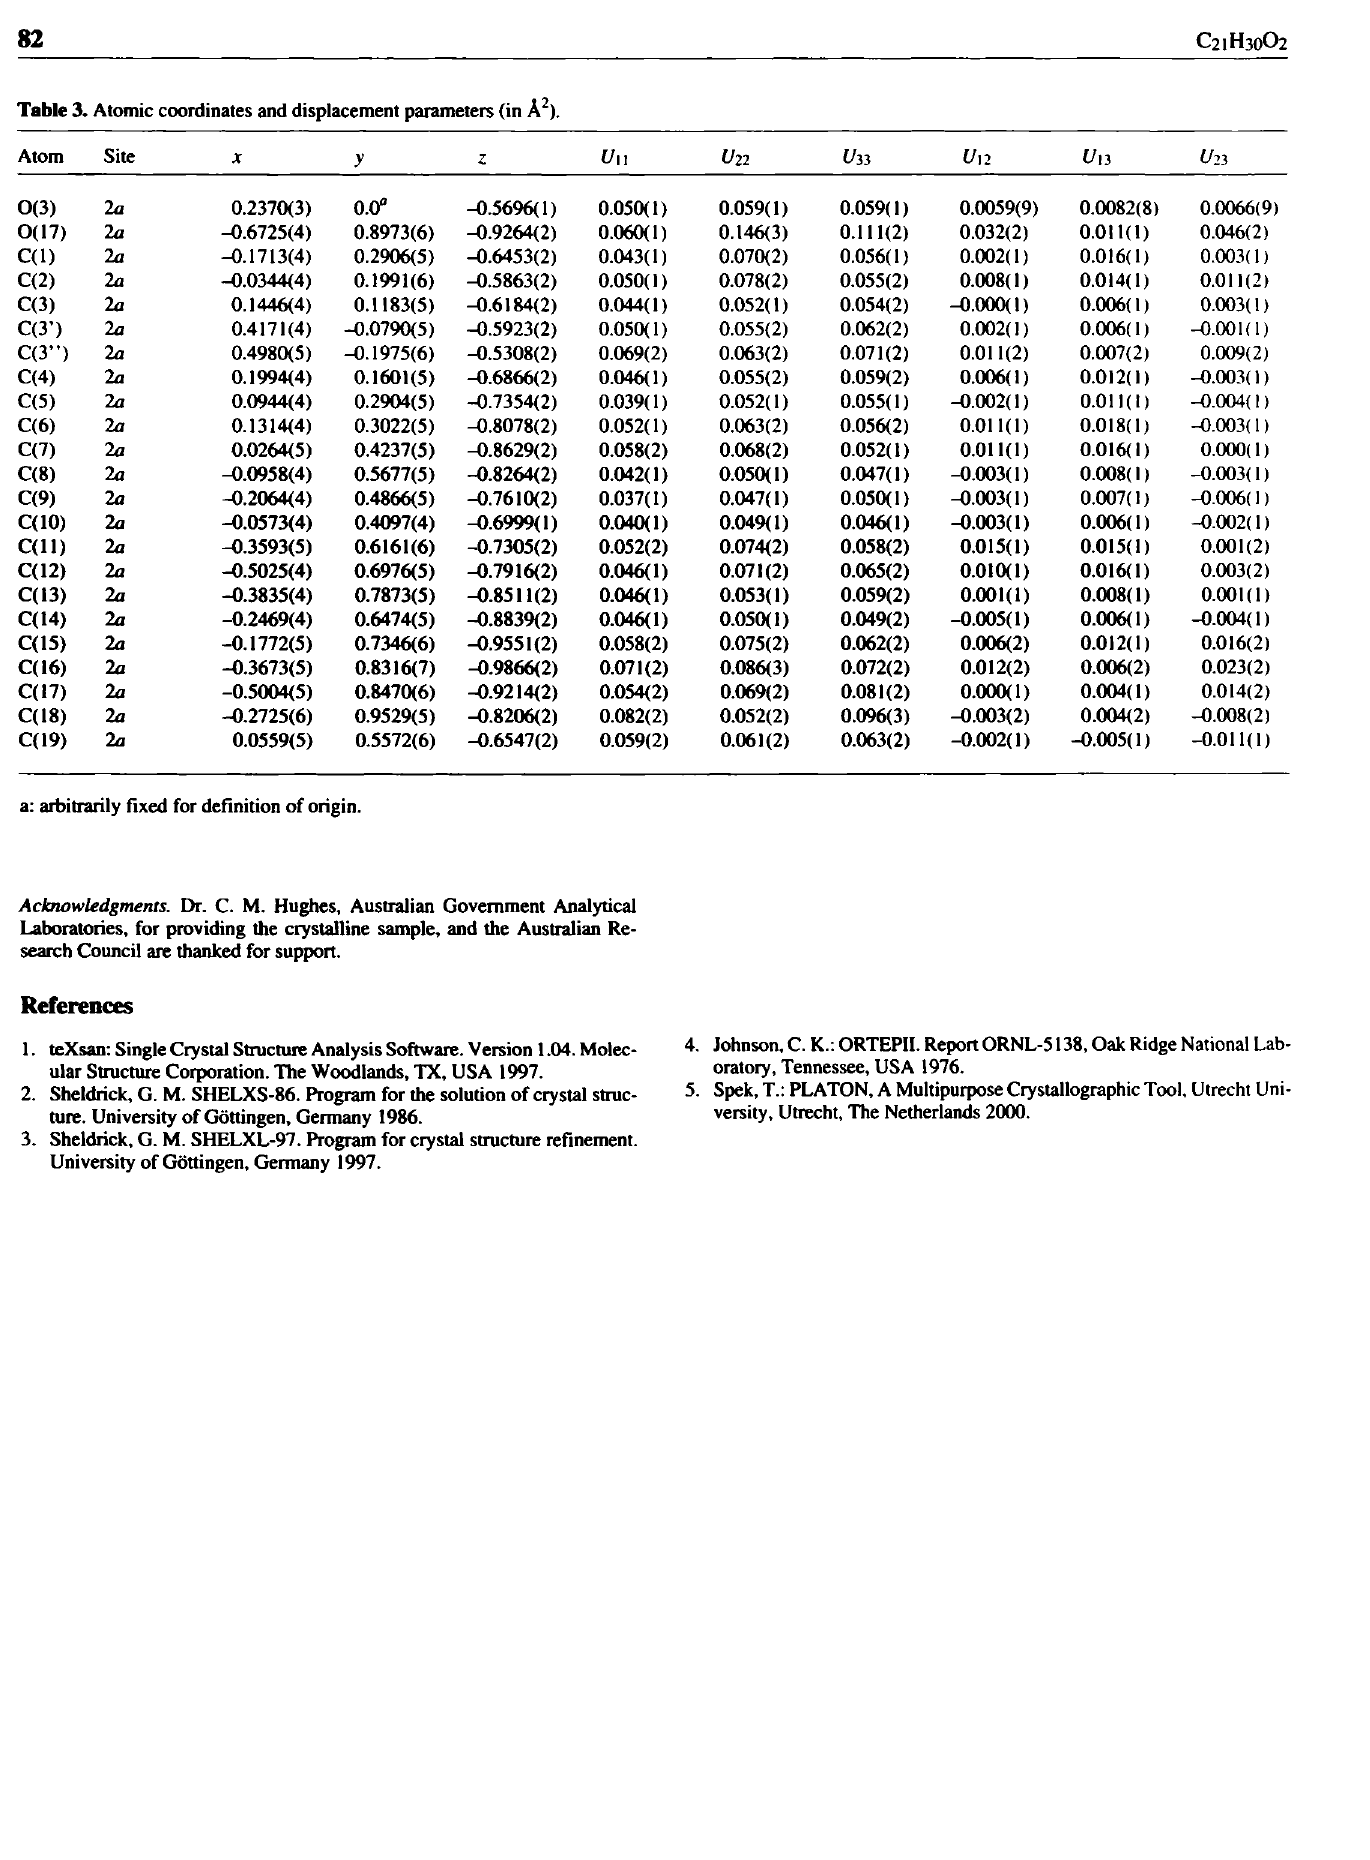
Table 3. Atomic coordinates and displacement parameters (in Â 2